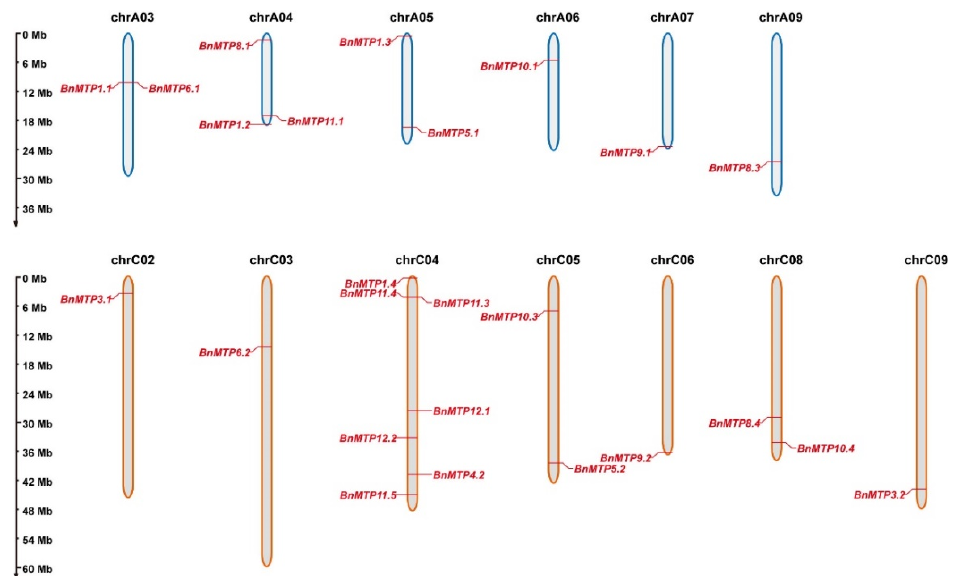
Figure 2. The gene structure and motif pattern of the MTP gene family in B . napus . ( A ) The exon– intron structure of BnMTP genes. Green boxes indicate 5 ′ - and 3 ′ -untranslated regions (UTR), yellow boxes indicate exons, and black lines indicate introns. ( B ) Conserved motifs of BnMTP proteins. Motif 1–15 identified by MEME analysis are displayed in different colored boxes.